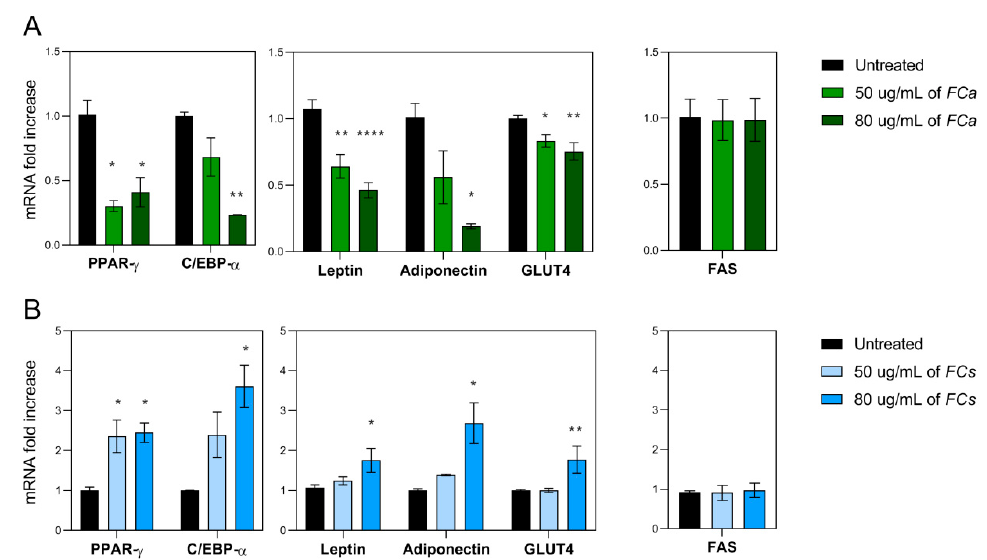
Figure 4. mRNA expressions of pro-adipogenic genes in 3T3-L1 adipocytes treated with Ficus carica phytoextract collected ( A ) in autumn (FCa,) and ( B ) in spring (FCs). mRNA expression of adipogenic transcription factors such as PPAR γ and C/EBP α and of their related target genes as Leptin, Adiponectin and GLUT4. Additionally, the gene expression of the adipogenic enzyme FAS has been analyzed. Data are shown as mean ± SEM; * p < 0.05; ** p < 0.01; **** p < 0.0001 vs. control group (untreated).